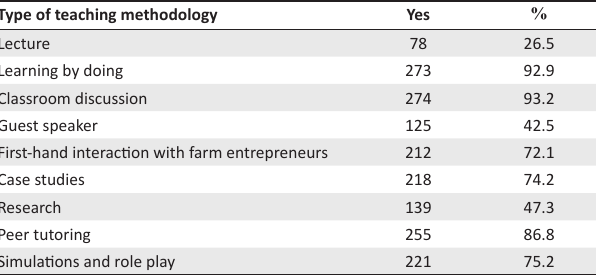
TABLE 4: Teaching methods in Folk Development Colleges ( N = 294). Type of teaching methodology